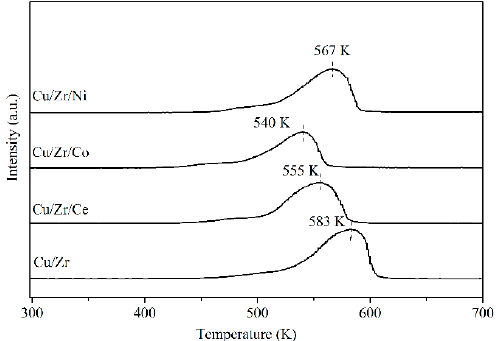
Figure 3. Temperature-programmed reduction of H 2 (H 2 –TPR) profiles of tested catalysts.